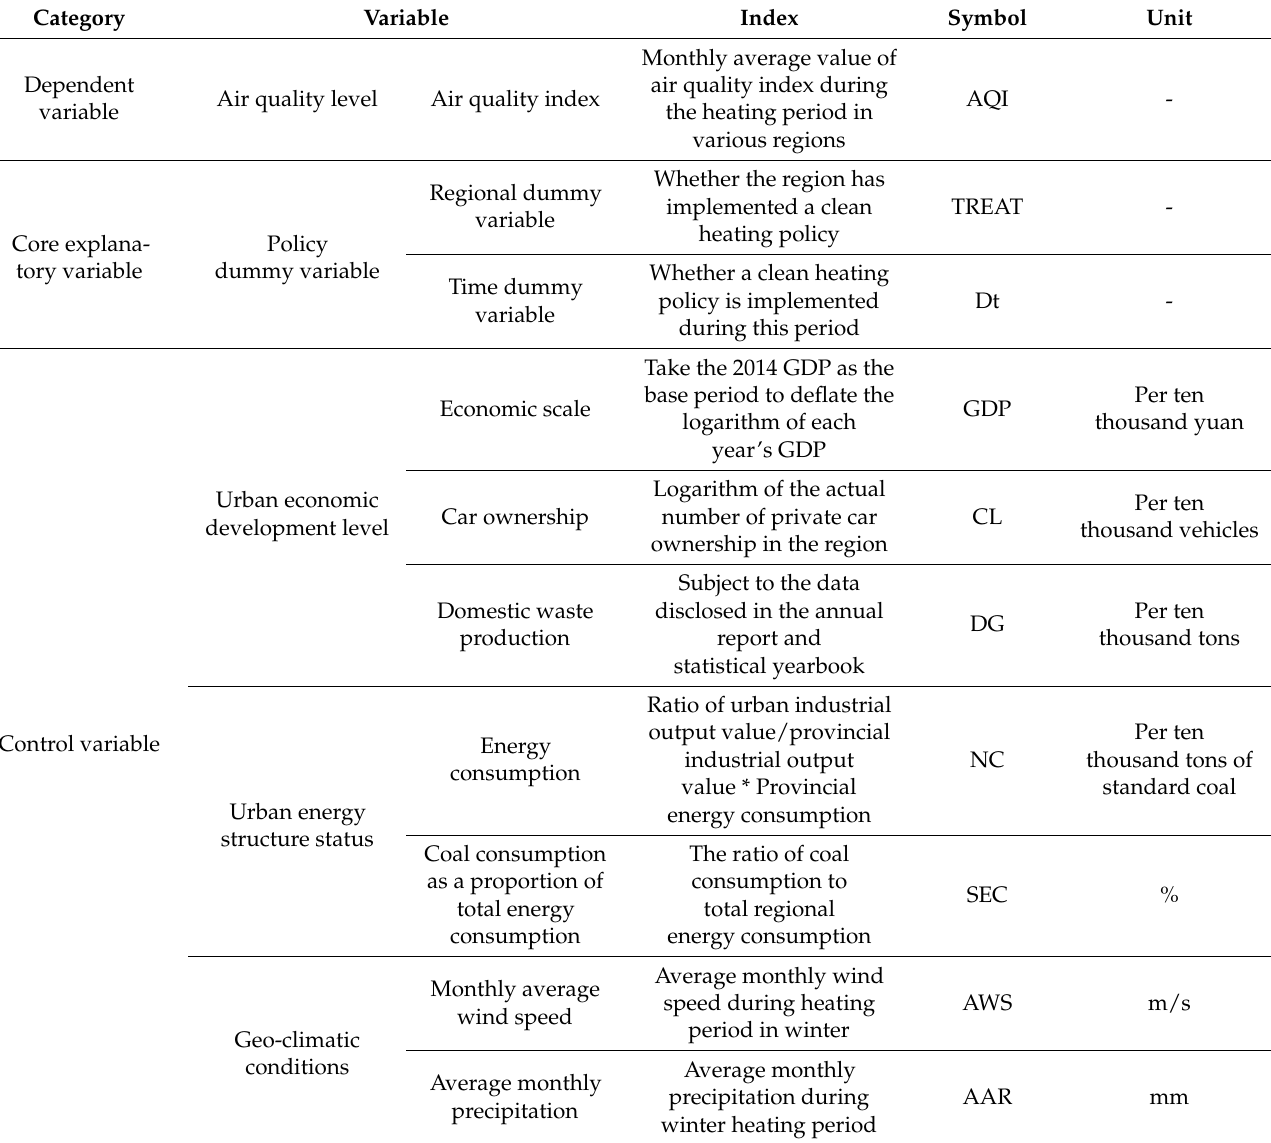
Table 1. Main variables and the specific calculation